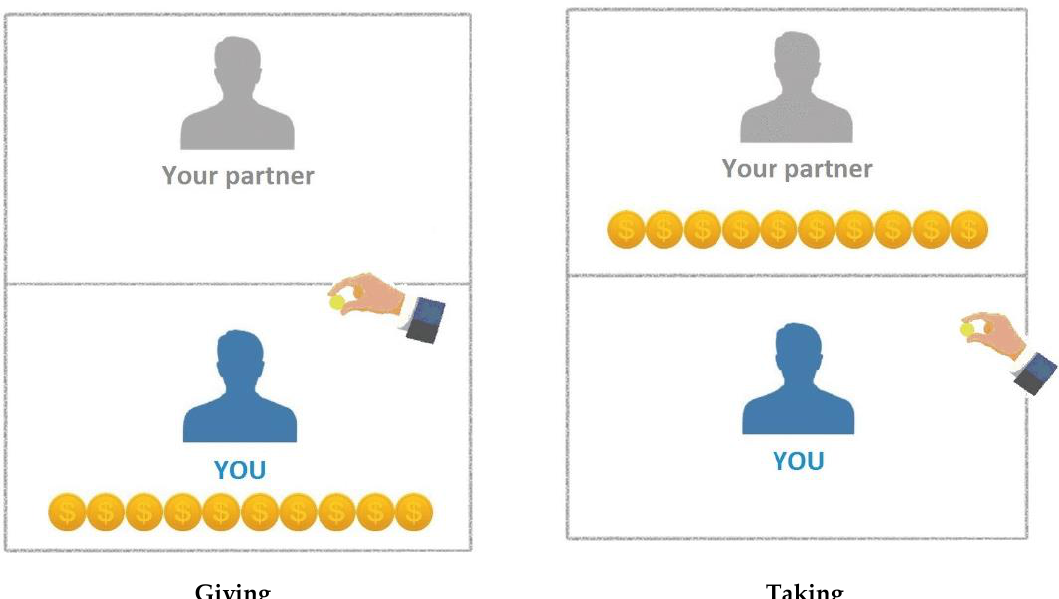
Giving Taking Figure 1. Screenshots of visualizations presented to participants in the giving ( left ) and taking ( right ) dictator games. The giving game featured a moving Graphics Interchange Format (GIF) image of a hand depositing a coin at the partner’s side of the table, while the taking game featured a moving GIF image of a hand retrieving a coin from the partner’s side of the table.